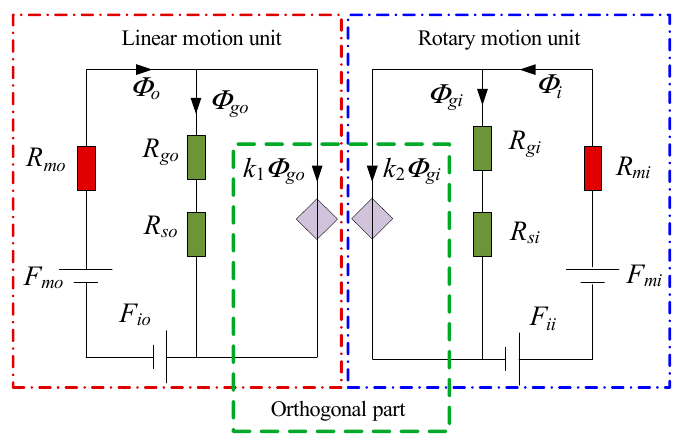
Figure 7. Equivalent magnetic model of the DSLRPMM with Maxwell’s resultant flux.